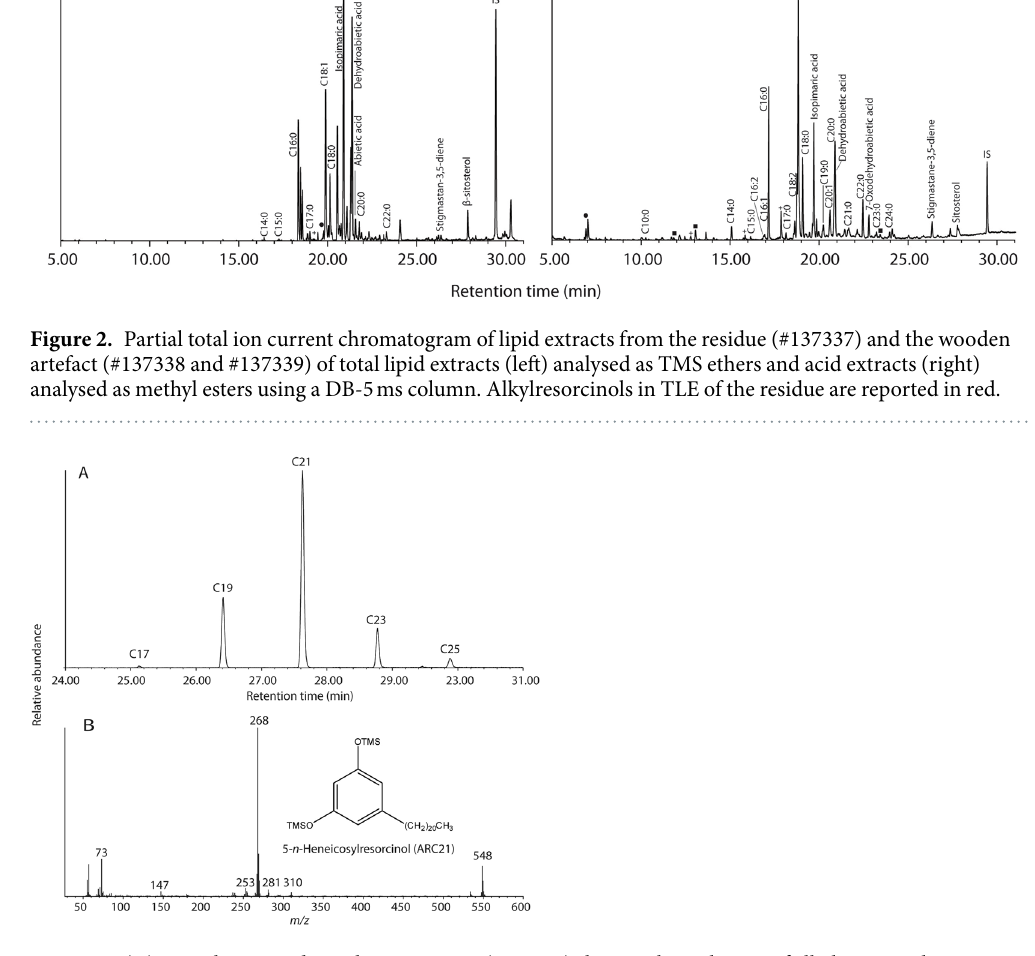
Figure 3. ( A ) Partial extracted ion chromatogram (m/z 268) showing homologues of alkylresorcinols (1,3-dihydroxy-5-alkylbenzenes) with alkyl chains of 17 to 25 carbon atoms in an extract of sample #137337- TLE; ( B ) selected mass spectra and structural information for 5-n-Heneicosylresorcinol TMS ester containing an alkyl chain of 21 carbon